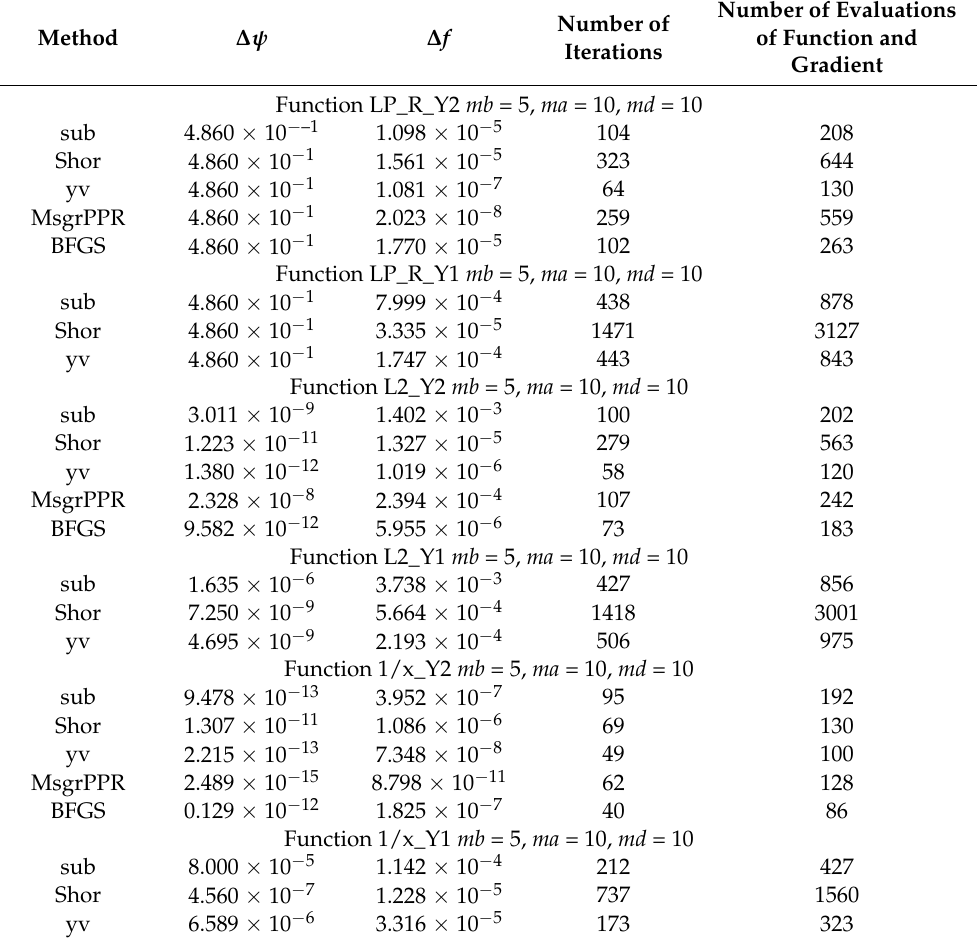
Table 2. Results of calculations for dimensions n = 1000, m = 100 with mb =